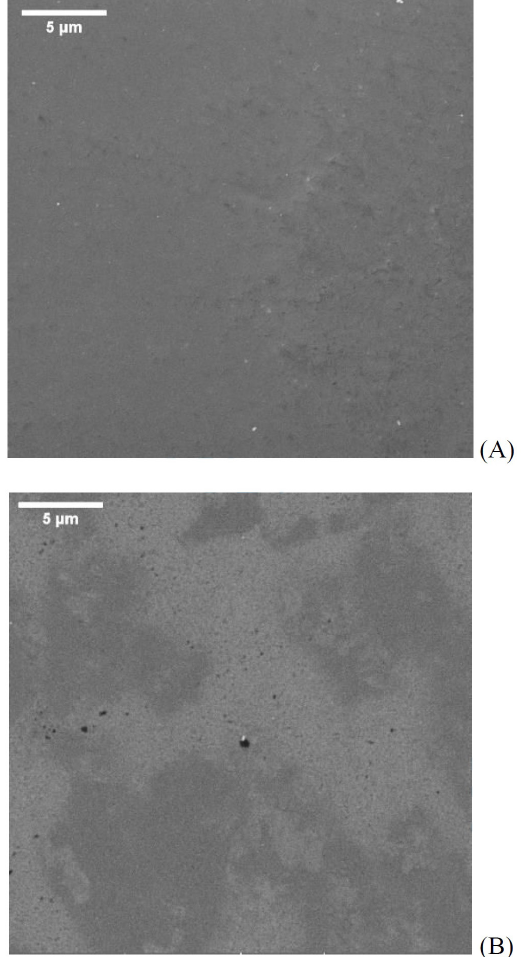
Figure 2. SEM images of (A) Ti control and of (B) Ti/Ag-10 min plasma